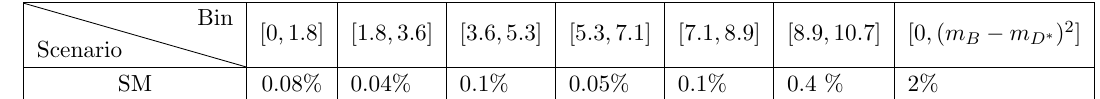
Table 3. Relative di(cid:11)erence in percent of the approximate binned expression of h ~ F D (cid:3) alt respect to the \standard" h ~ F D (cid:3) i 0 for the SM. It corresponds to the relative di(cid:11)erence in between T the orange and blue bins displayed in (cid:12)gure 1 (normalised by the \standard" h ~ F D (cid:3) orange bins). The bins in the (cid:12)rst 6 columns correspond to the division of the kinematic range ([0 ; ( m B (cid:0) m D (cid:3) ) 2 ]) in 6 equally sized intervals. The last column corresponds to the whole kinematic range (not displayed in (cid:12)gure 1). Notice that, as expected, this approximation works better for smaller bins.